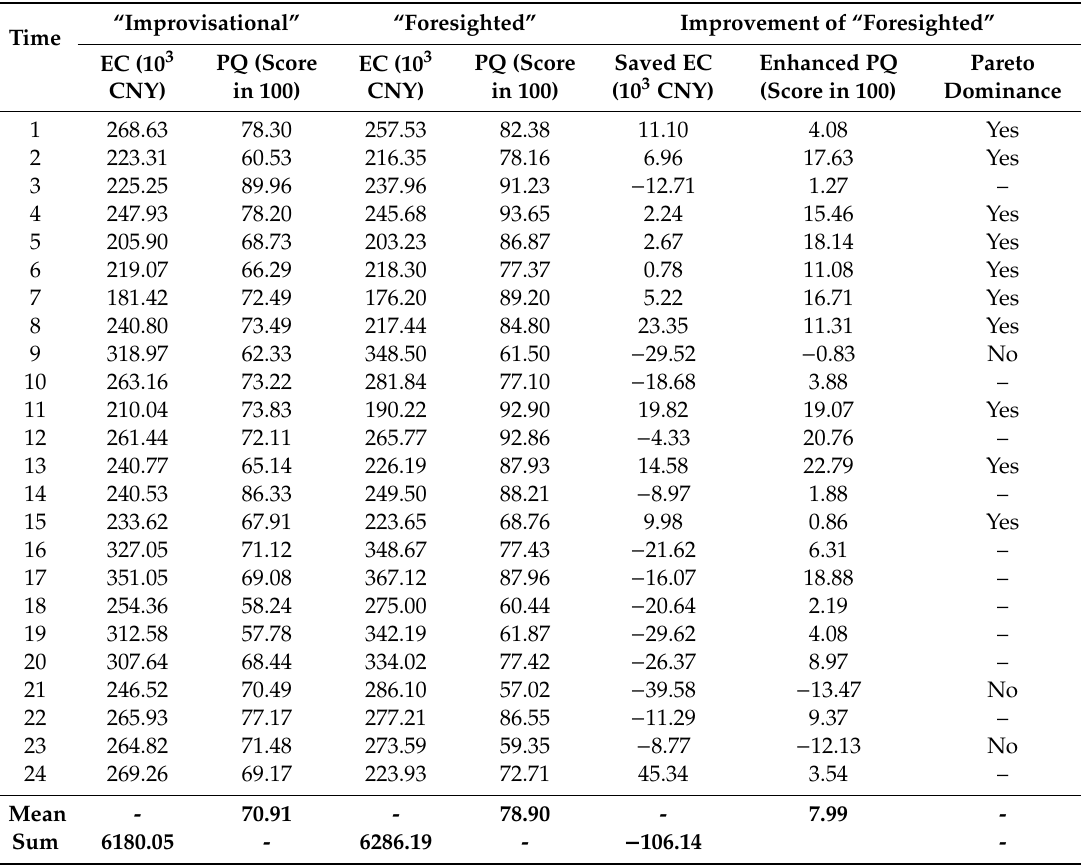
Table 4. Comparison of Pareto-optima of two strategies: “improvisational” and “foresighted”. “Improvisational” “Foresighted” Improvement of Time